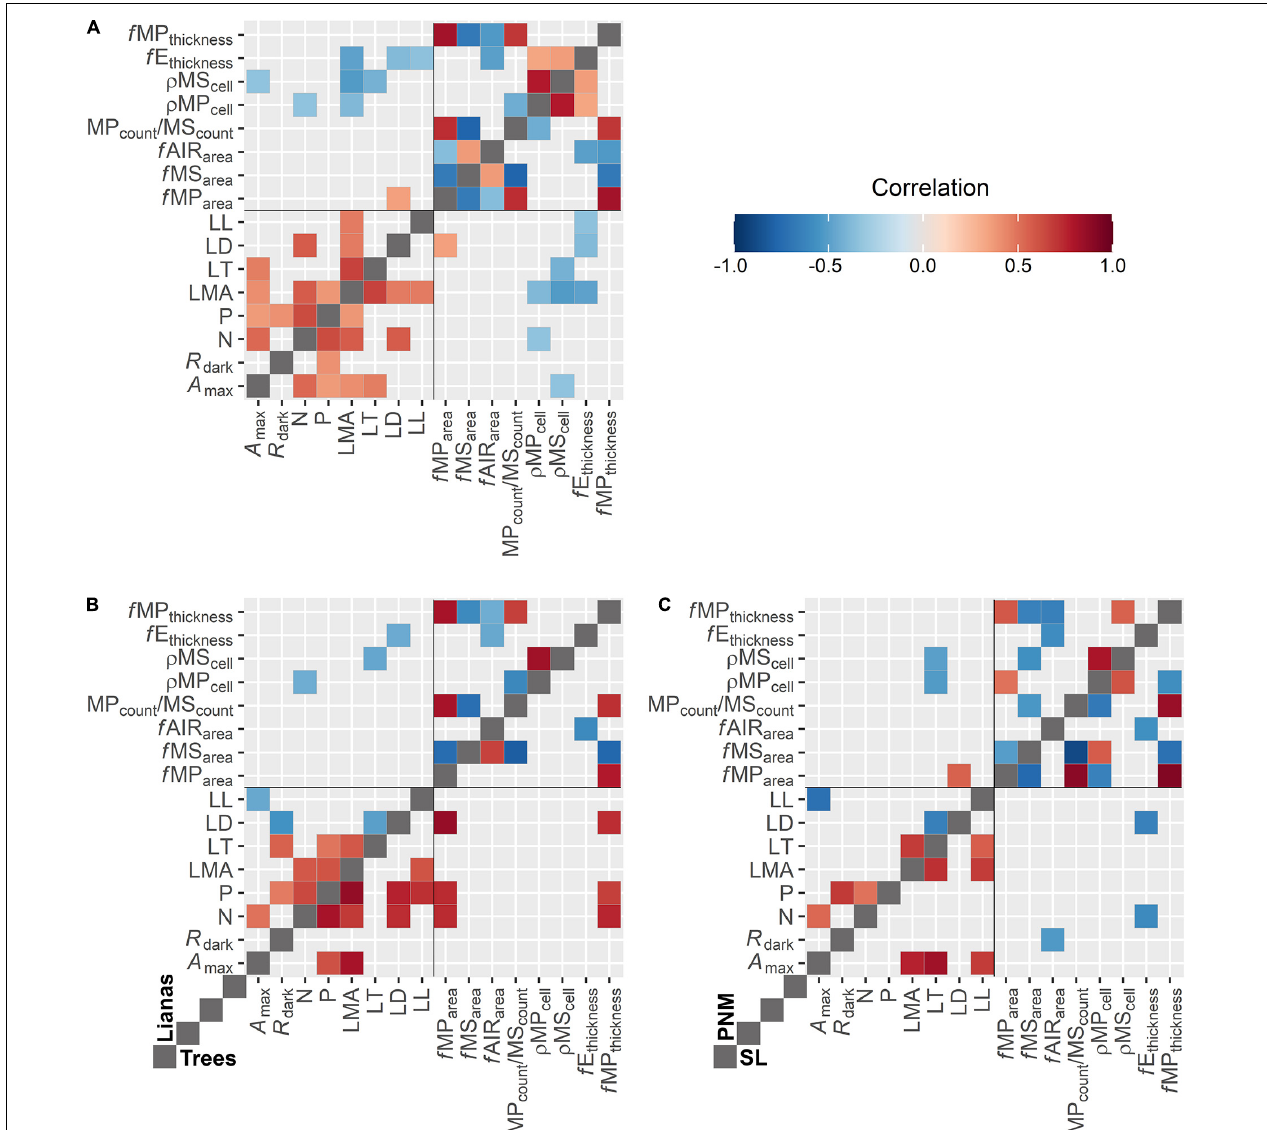
FIGURE 2 | Correlation analysis between leaf anatomical traits and well-established leaf functional traits. All species (A) , life forms (B) , and forest type ( C ; PNM: Parque Natural Metropolitano and, and SL: Parque Nacional San Lorenzo). The colours show the bootstrapped pairwise Pearson correlation that are significant ( p > 0.05). The grey grid of the middle divides the upper and lower the correlation results between life forms (A) or forest type (B) . An extended figure with all the correlation was attached as Supplementary Figure 1